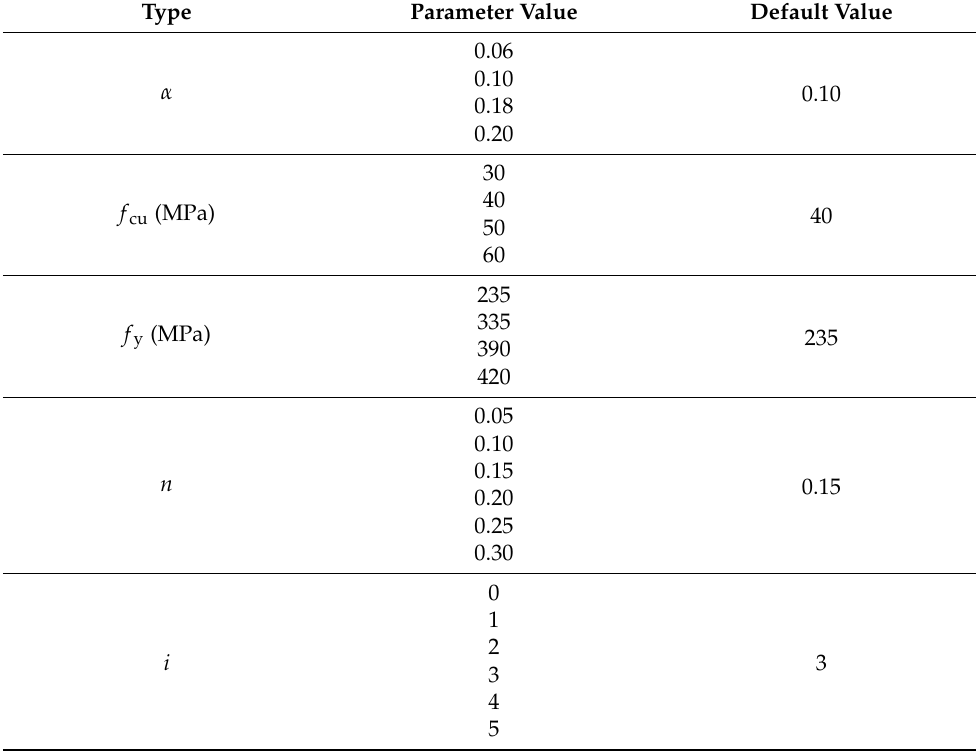
Table 3. Main parameters of CFST pier columns in FE